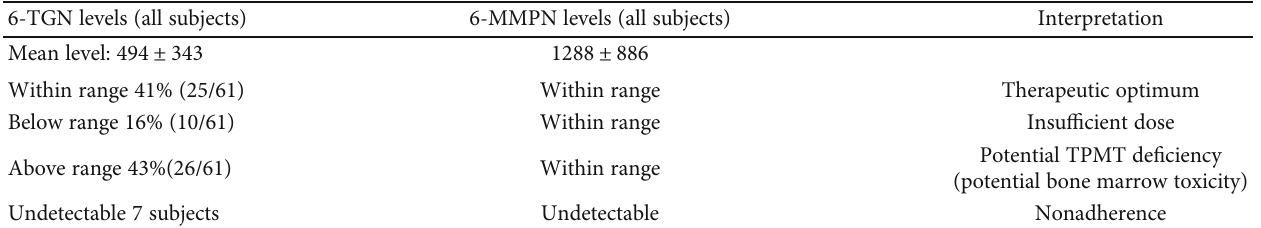
Table 3: Metabolite levels. Mean standard deviations and the range of values of 6-thioguanine (6-TGN), 6-methylmercaptopurine (6-MMPN), measured in pmol/ 8 × 10 8 erythrocytes.